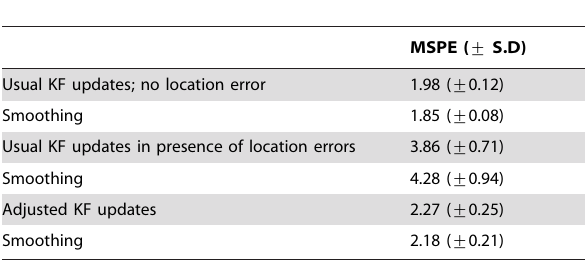
Table 2. Mean MSPE ( + standard deviation) of a 1000 simulated dat sets with predictions from Kalman filtering and Kalman